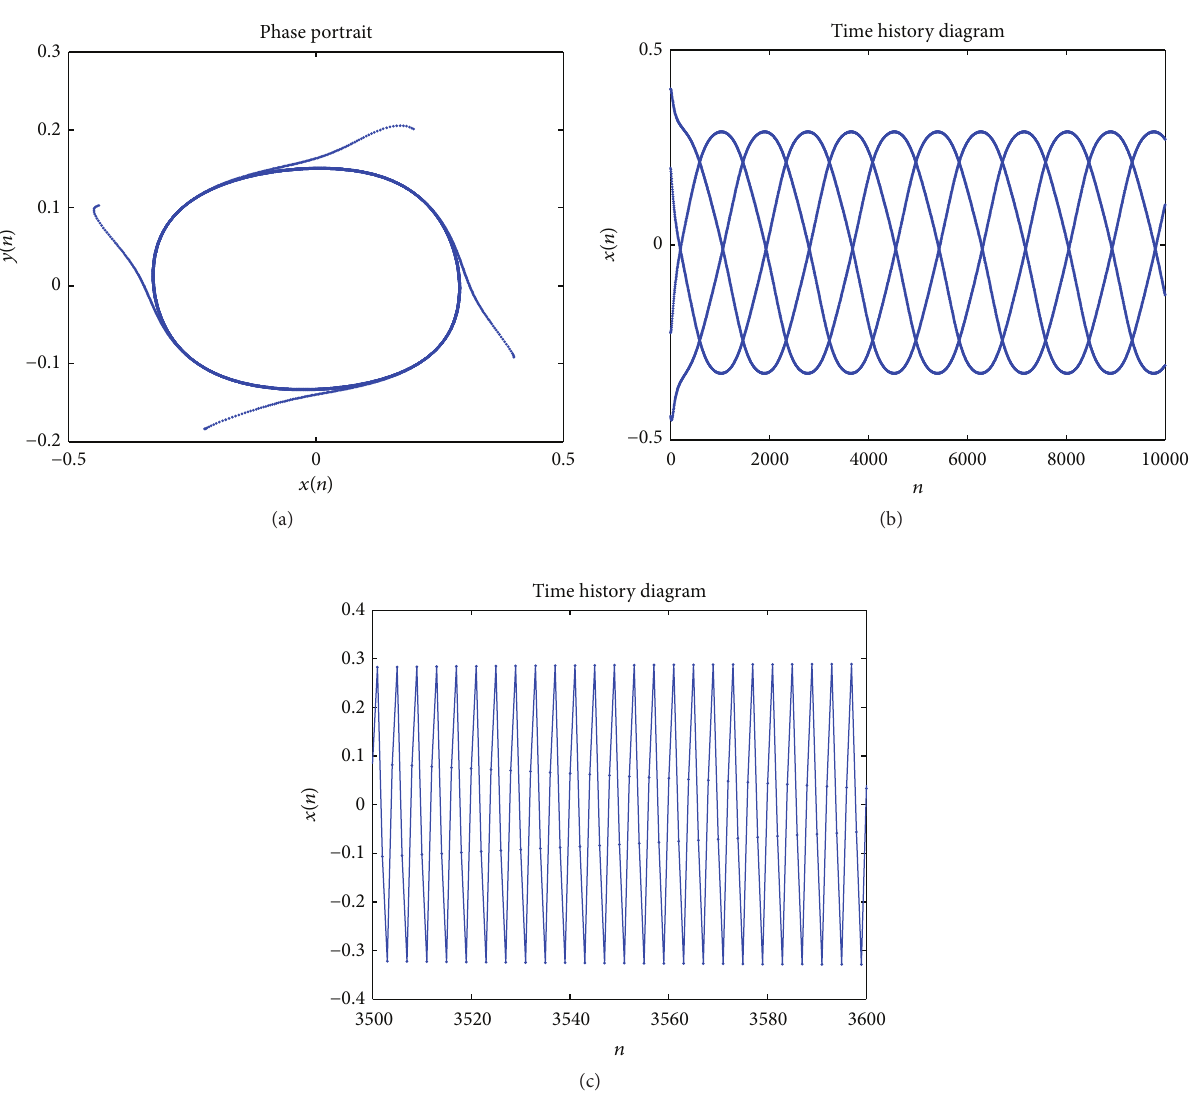
Figure 5: (a) Phase portrait and (b) time history diagram of equivalent deterministic system (6) with 𝑑 = −0.508 . (c) Local amplification corresponding to